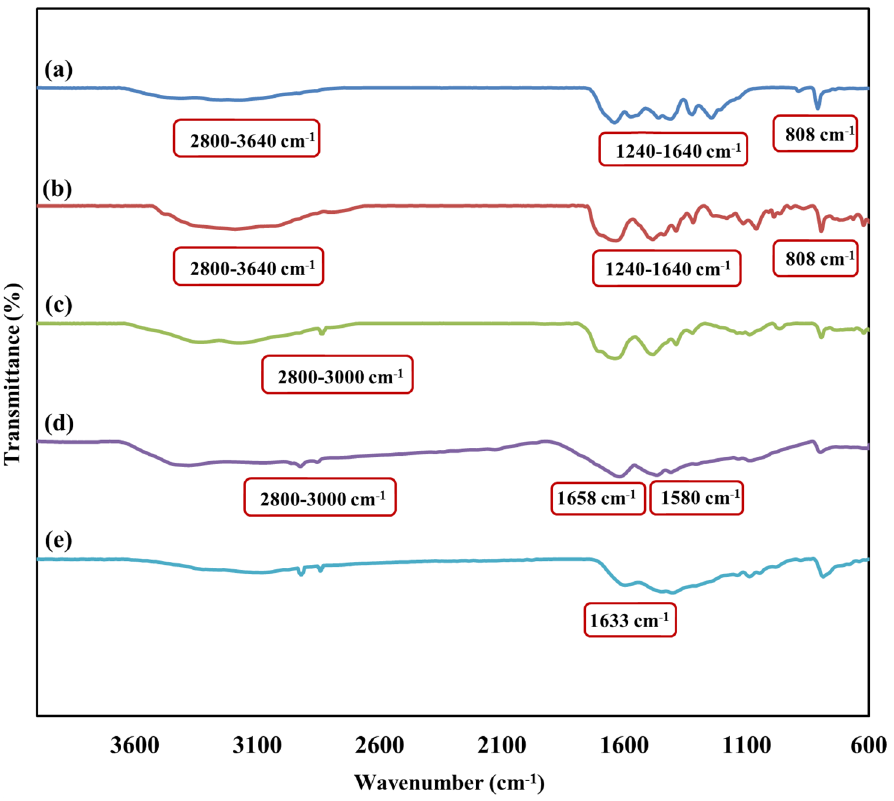
Figure 2. FT-IR spectrum of (a) bulk g-C 3 N 4 , (b) CN, (c) CN–Pr–Br, (d) CN–Pr–Met and (e) CN–Pr–Met–